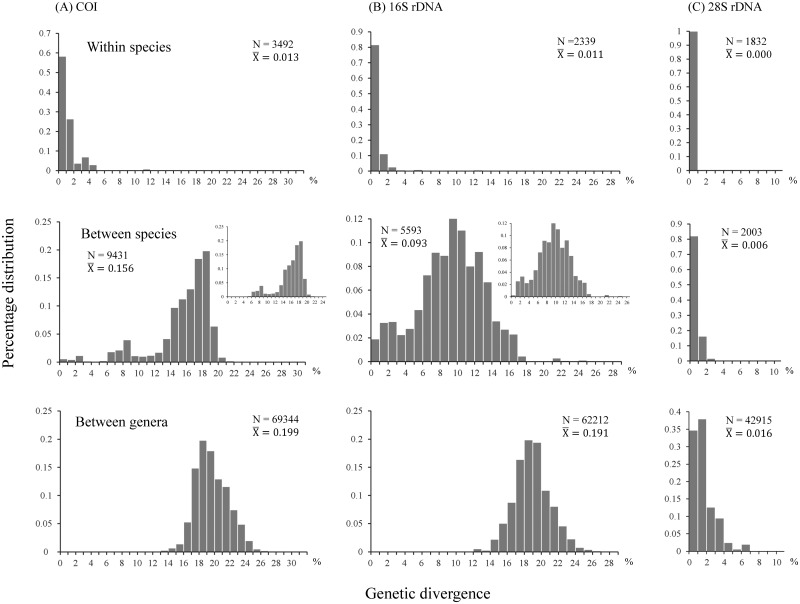
Genetic variations (p-distance) of COI (A), 16S rDNA (B), and 28S rDNA (C) in Lucanidae.Nucleotide divergence of pairwise comparisons for individuals within species (upper), for species within genera (middle), and among genera of Lucanidae (bottom) are shown. Relevant data excluding those of taxonomically debated species are shown in the upper right panel.